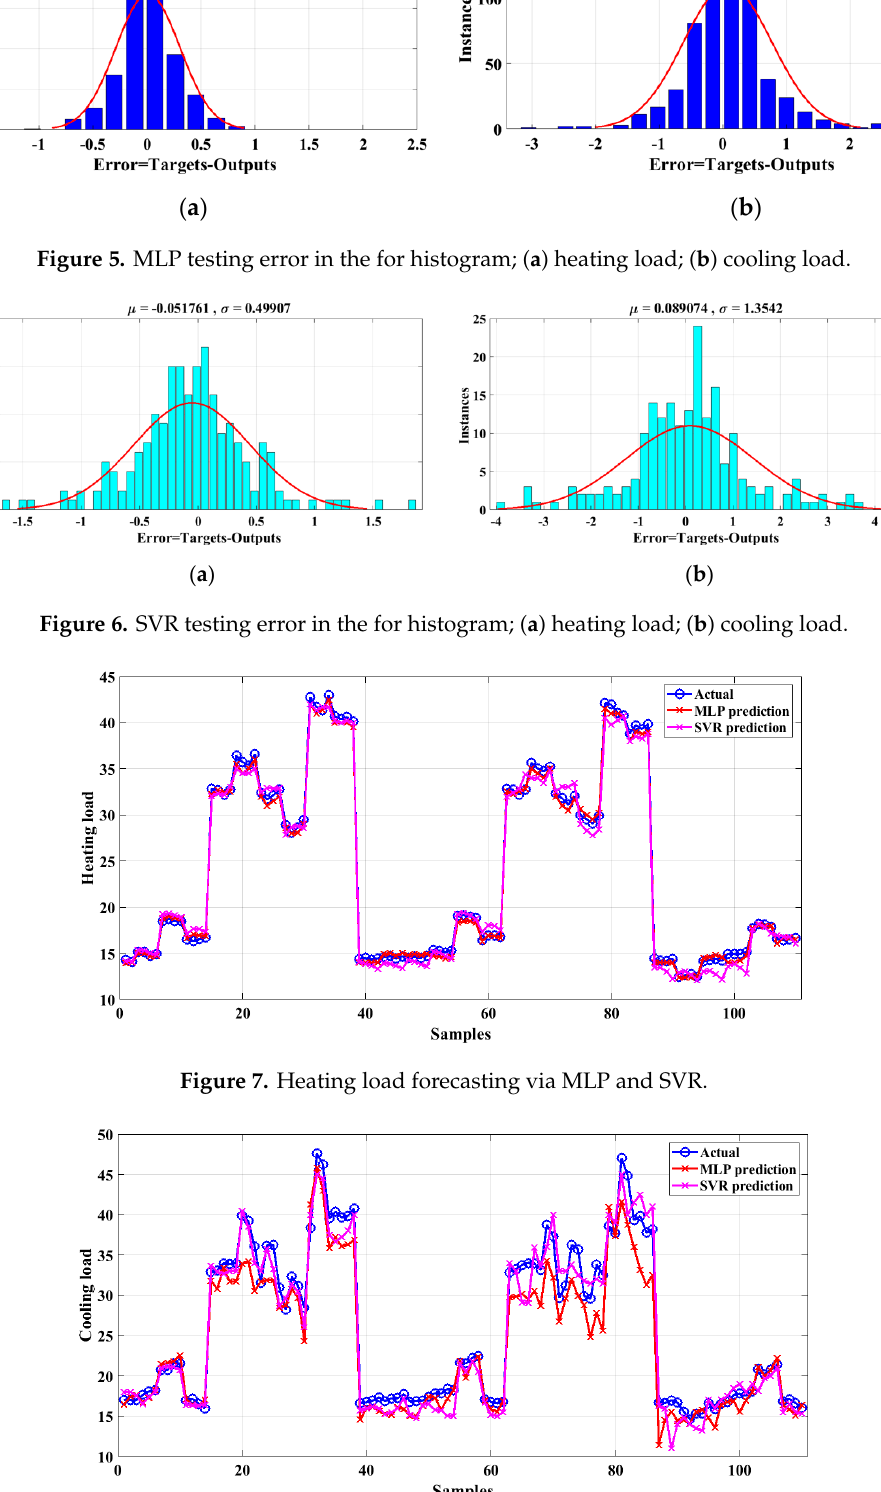
Table 2. Results of accuracy and error for proposed methods in heating and cooling load prediction.